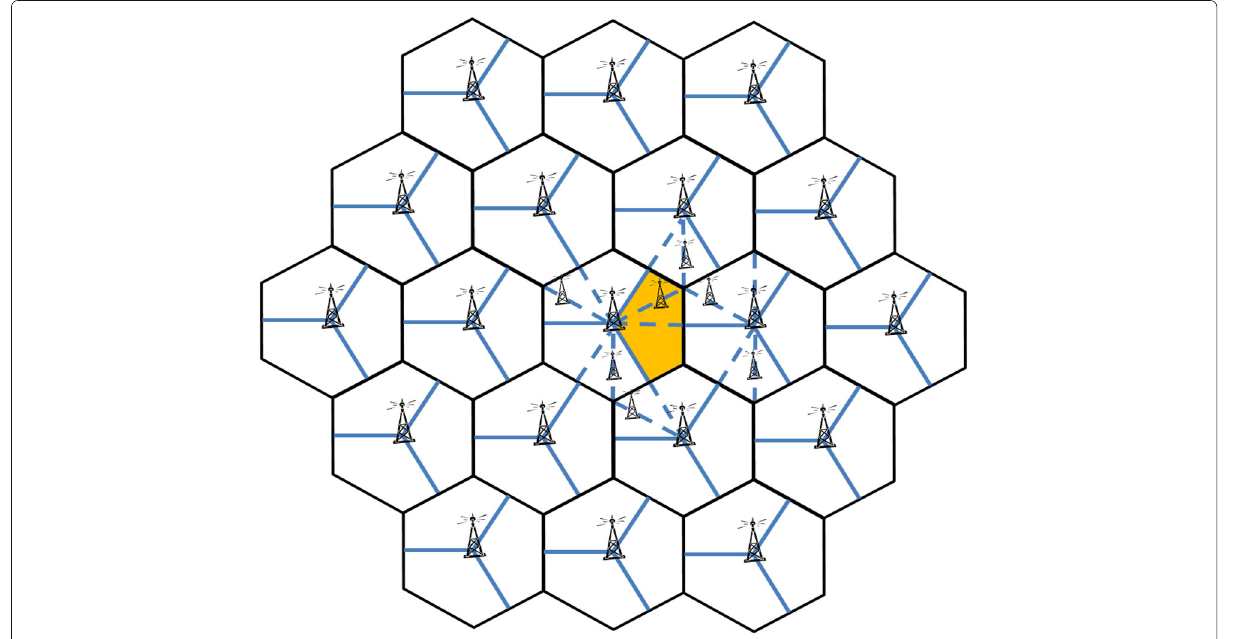
Fig. 2 19-hexagonal-cell site model